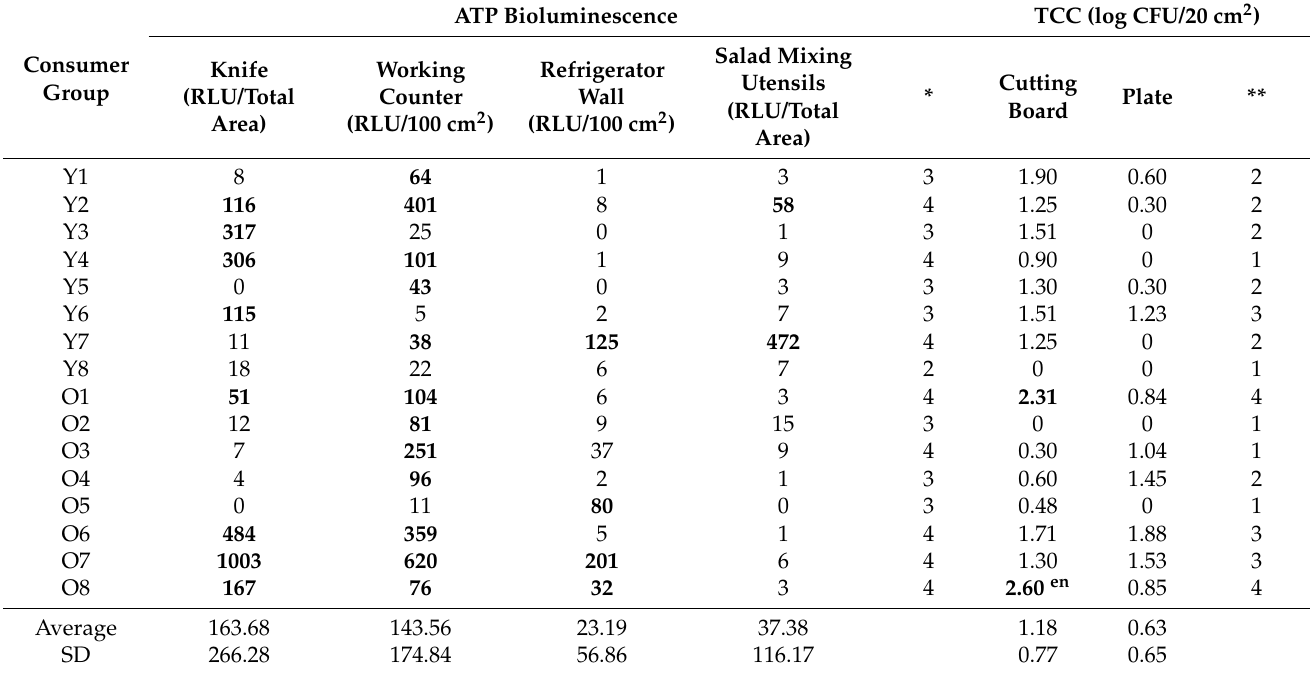
Table 4. Cleanliness of surfaces and utensils used by the observed consumers based on the ATP bioluminescence and total colony count